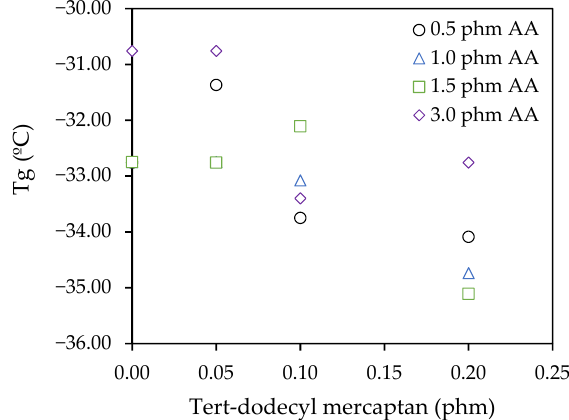
Figure 2. Effect of acrylic acid (AA) and TDM levels in the glass transition temperature (Tg). Figure 2. E ff ect of acrylic acid (AA) and TDM levels in the glass transition temperature